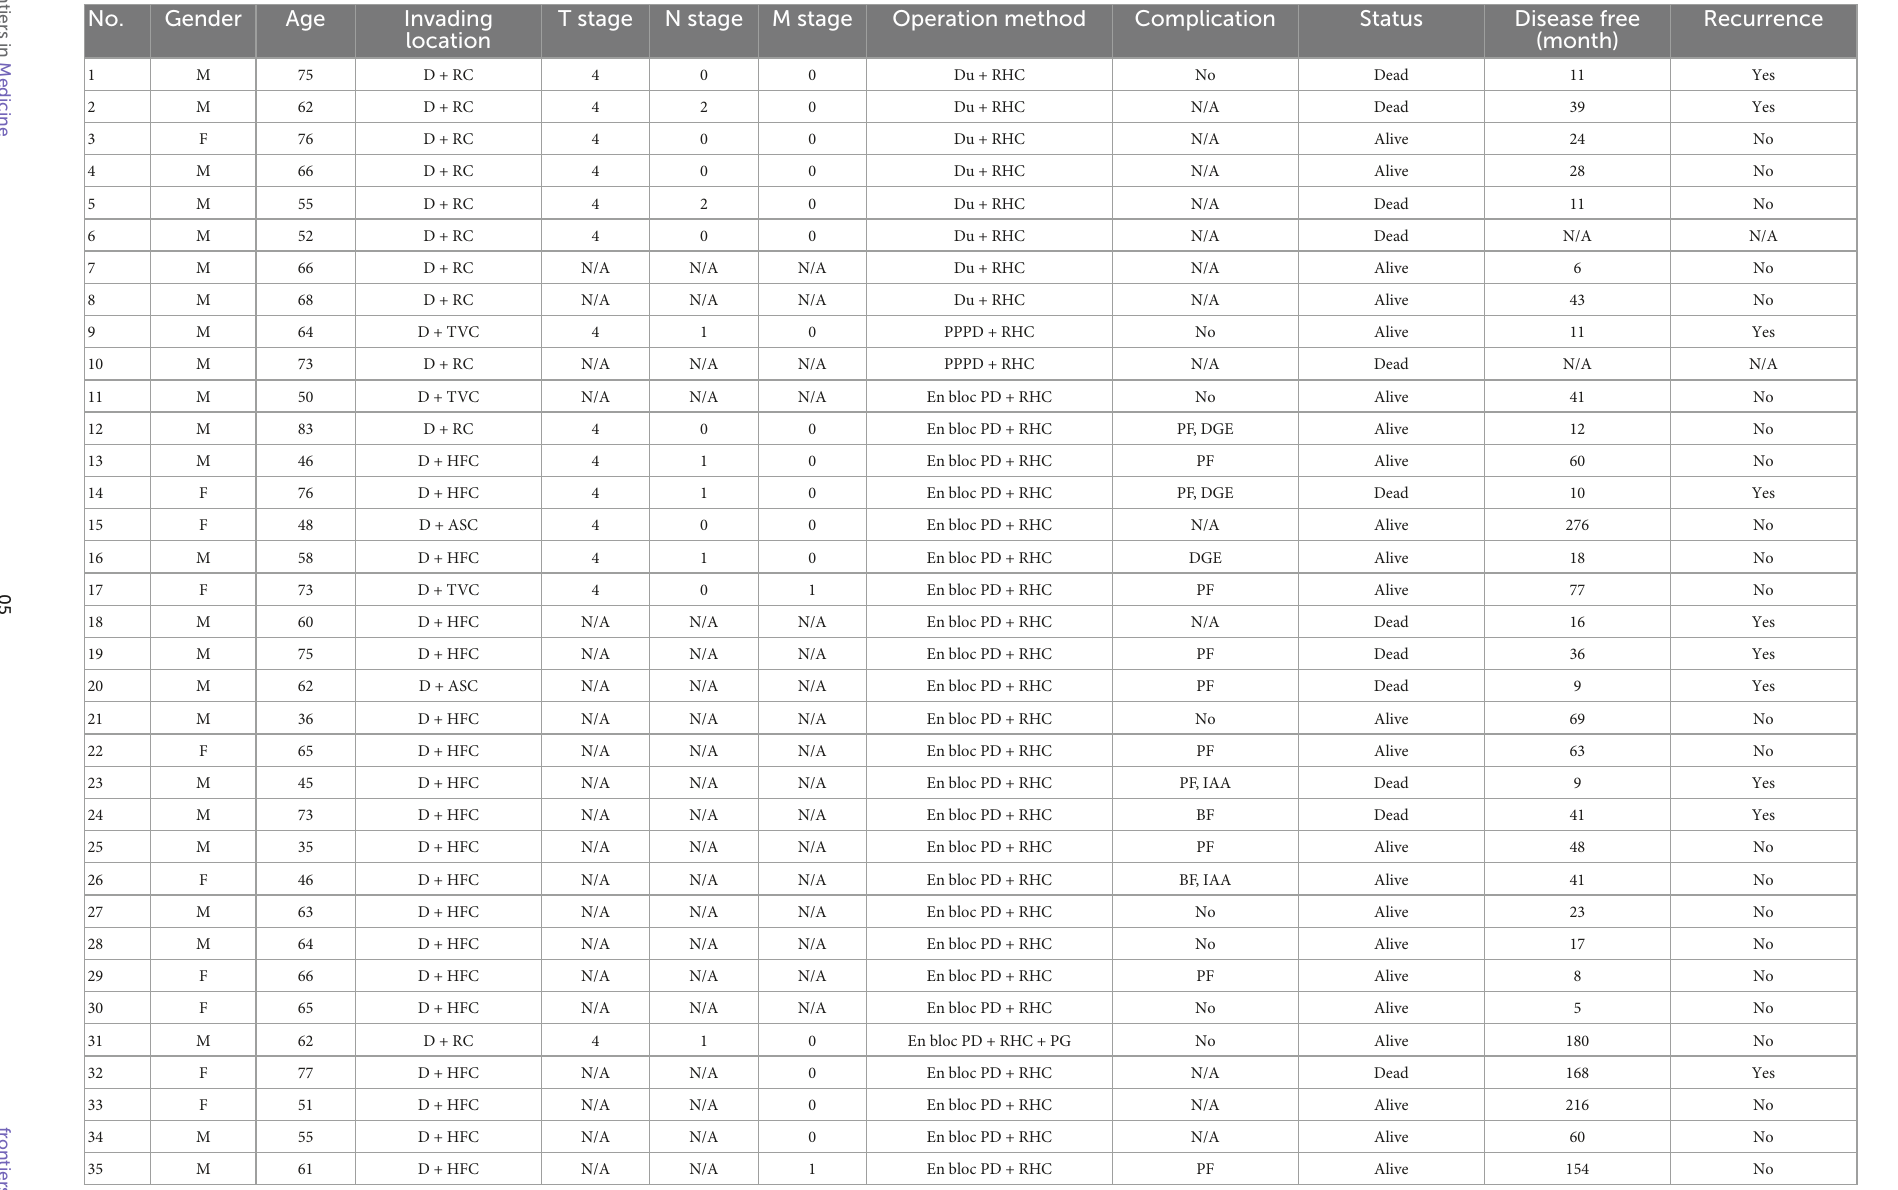
TABLE 2 The comparison of local pancreaticoduodenectomy and en bloc PD resection with RHC when right colon cancer (RCC) invaded duodenum.